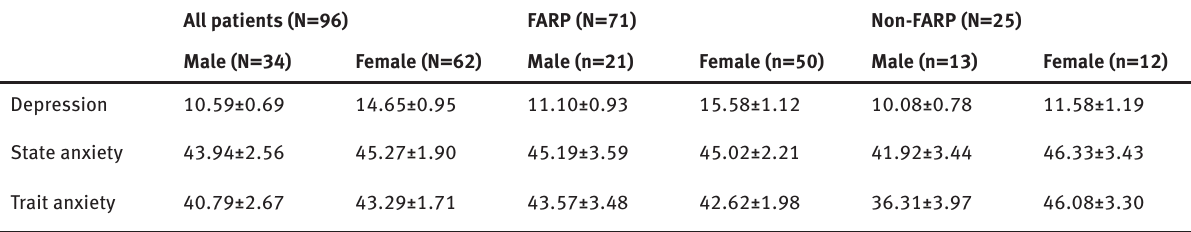
Table 6: Depression and anxiety scores for male and female FARP and non-FARP patients